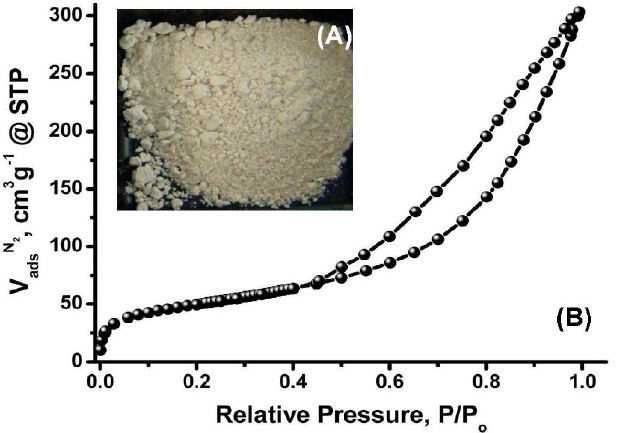
Figure 2. Representative TEM micrographs of MS/AgNP materials; Ag loading